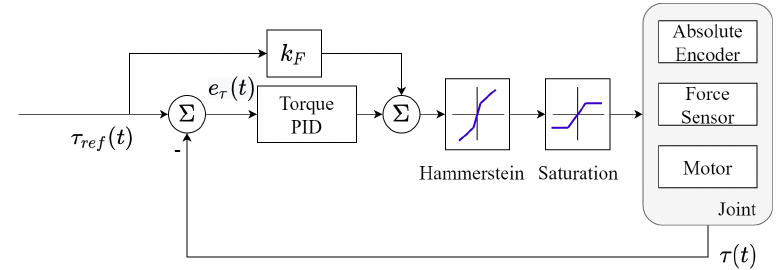
Figure 12. Force controller block